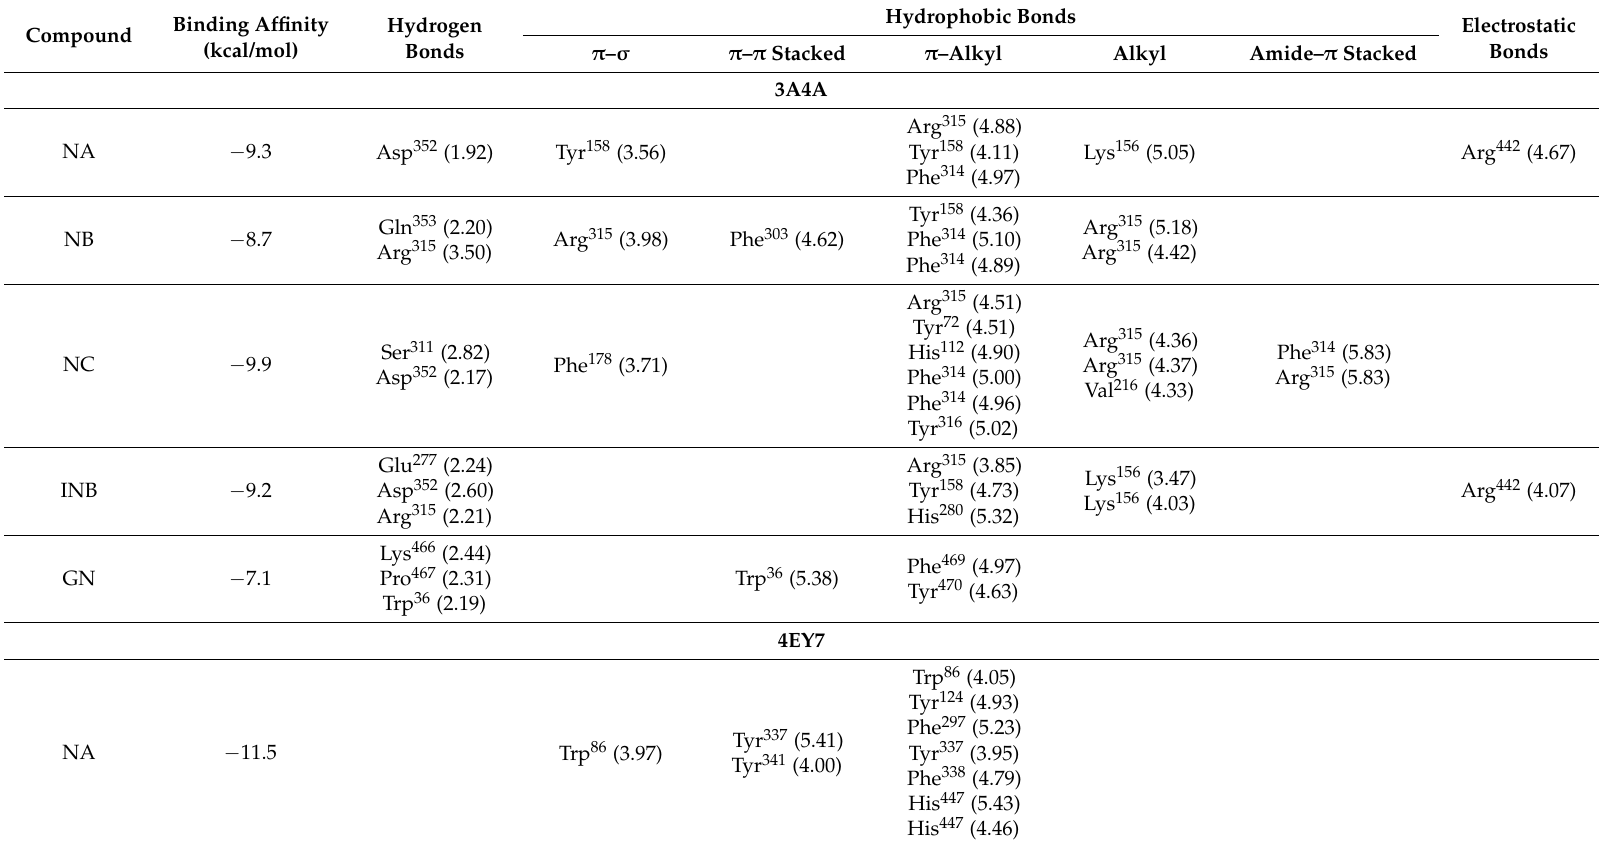
Table 2. Binding affinity and binding interactions of Okinawa propolis (OP) compounds with α -glucosidase (Protein Data Bank identifier (PDB ID): 3A4A) and acetylcholinesterase (PDB ID: 4EY7)